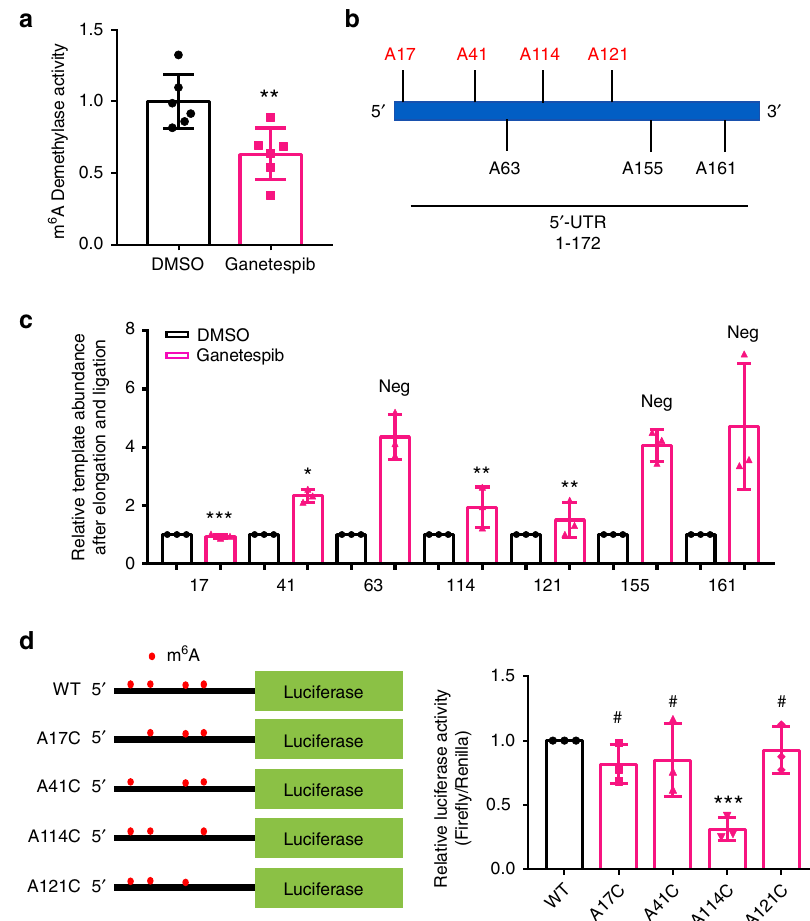
Fig. 6 Ganetespib induces DNAJB4 translation via m 6 A in its 5 ′ -UTR. a Displayed is a bar graph showing that the activity of m 6 A demethylase is decreased in M14 cells after a 6-h treatment with 100 nM ganetespib ( n = 6). b A diagram showing the 5 ′ -UTR of the human DNAJB4 mRNA and the adenosine sites monitored by the SELECT assay. The adenosine sites marked in red and black are the m 6 A motif sites and the negative control sites, respectively. c Relative template abundances of the 5 ′ -UTR of DNAJB4 mRNA in M14 cells that are mocked treated with DMSO or treated with ganetespib for 6 h, as measured by the SELECT method with DMSO or ganetespib treated for 6-h ( n = 3). A total of seven sites were chosen, four from m 6 A motif site (G A C) and three from U A A or C A A sites (as negative control). ‘ Neg ’ represents negative control. The p -values were calculated versus the mean value of the three negative controls. d Relative luciferase activities for wild-type (WT) 5 ′ -UTR of DNAJB4 gene and the corresponding A → C mutants ( n = 3). Fire fl y luciferase activity was normalized to that of Renilla luciferase and further normalized to the wild-type construct. The data represent the mean ± S.D. of results obtained from three separate experiments. The p- values referred to comparison with the wild-type plasmid, and were calculated using unpaired, two-tailed Student ’ s t - test: # p > 0.05; *, 0.01 ≤ p < 0.05; **, 0.001 ≤ p < 0.01; ***, p < 0.001. Source data are provided as a Source Data fi